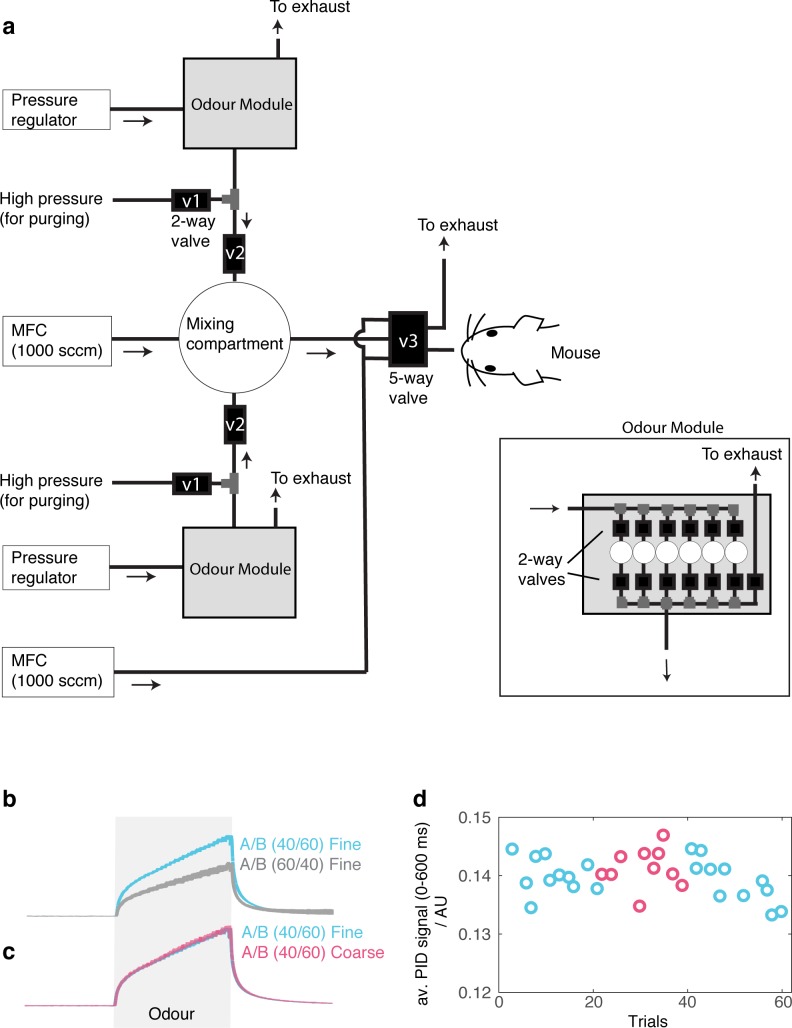
PID signals show stable odour pulses.(A) Olfactometer design for mixing two odorant streams at desired concentrations for generating binary mixtures. For each odorant, filtered and regulated air is passed through a selected odour canister by opening a pair of two-way solenoid valves ('Odour module'). Odourized air is passed through a second, fast solenoid valve (‘v2’) in a pulsatile manner. Pulses of odourized air are mixed in an enlarged compartment (a 50 ml flask) to remove transients. The odour concentration can be set by controlling background air flow and odorized pulse parameters (duration and frequency of rectangular pulses). Mixed air passes through thin PTFE tubing (O.D., 3.2 mm) and is presented to the animal when the 5-way solenoid valve is actuated. (B) For characterizing the stimulus profile, a photo-ionization detector was placed in front of the odour port, in place of the mouse. Instead of the usual binary mixtures, the test used a mixture of 1 odorised stream and one blank stream (passing air through an empty odour vial) mixed in the same way to test the concentration of each component separately. PID signals from trials where the composition of the tested odour is 60% (cyan) vs 40% (gray), corresponding to the composition of an odour ‘A’ in S+ and S- trials, respectively. (C) Odour concentrations (PID signal) measured during coarse and fine discrimination for the switching paradigm are overlaid. Mean +- standard error of the mean shown (~15 trials each). (D) Time-course of odour concentrations to test the depletion level during a task-switch session. The inter-trial interval was approximately 20 s. Data shown are the average PID signal during the first 600 ms of odour period.